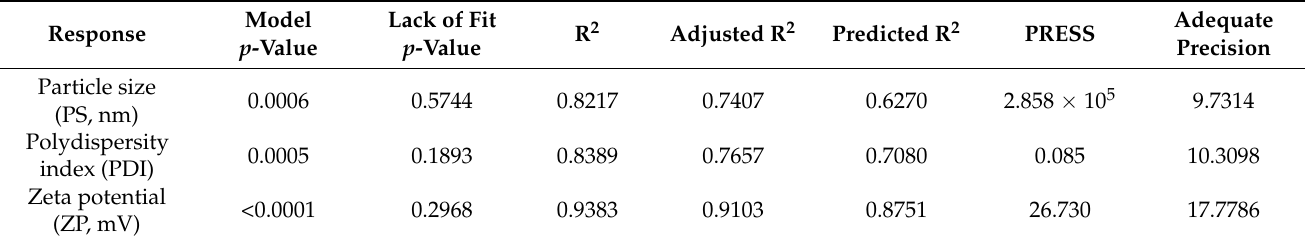
Table 3. Fit statistical summary of the quadratic × linear model for SMV-SPNs